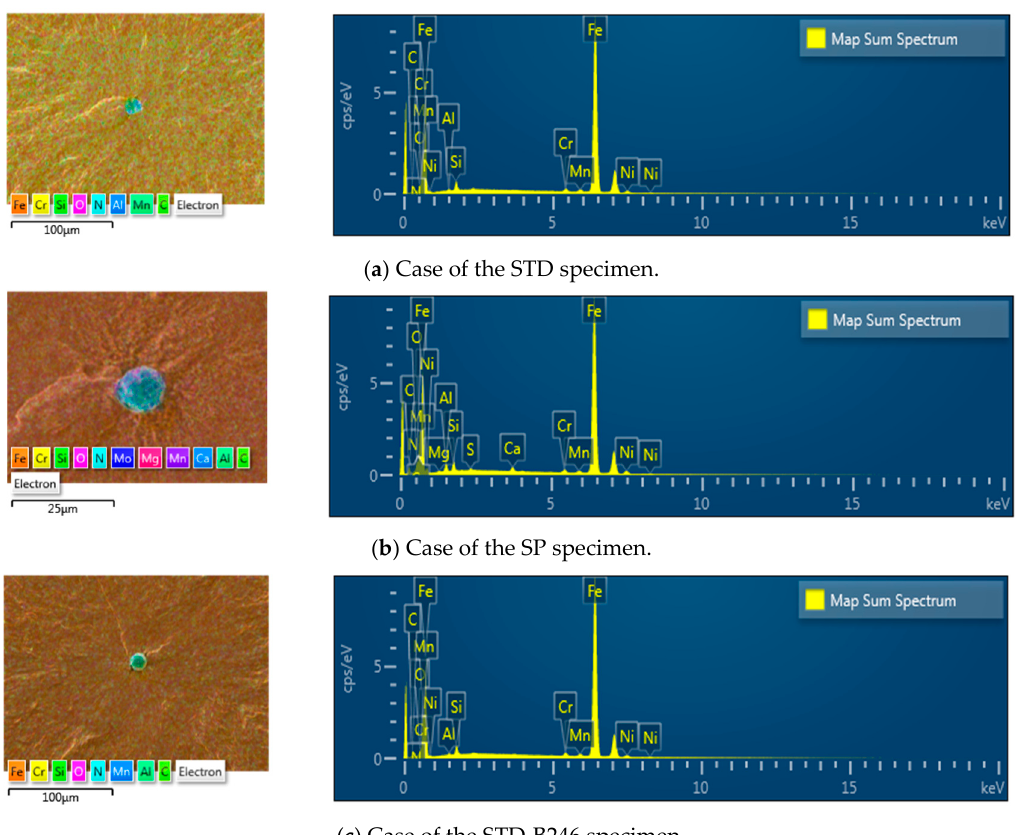
Figure 9. EDS spectra of the inclusion which occurred in the used specimens.